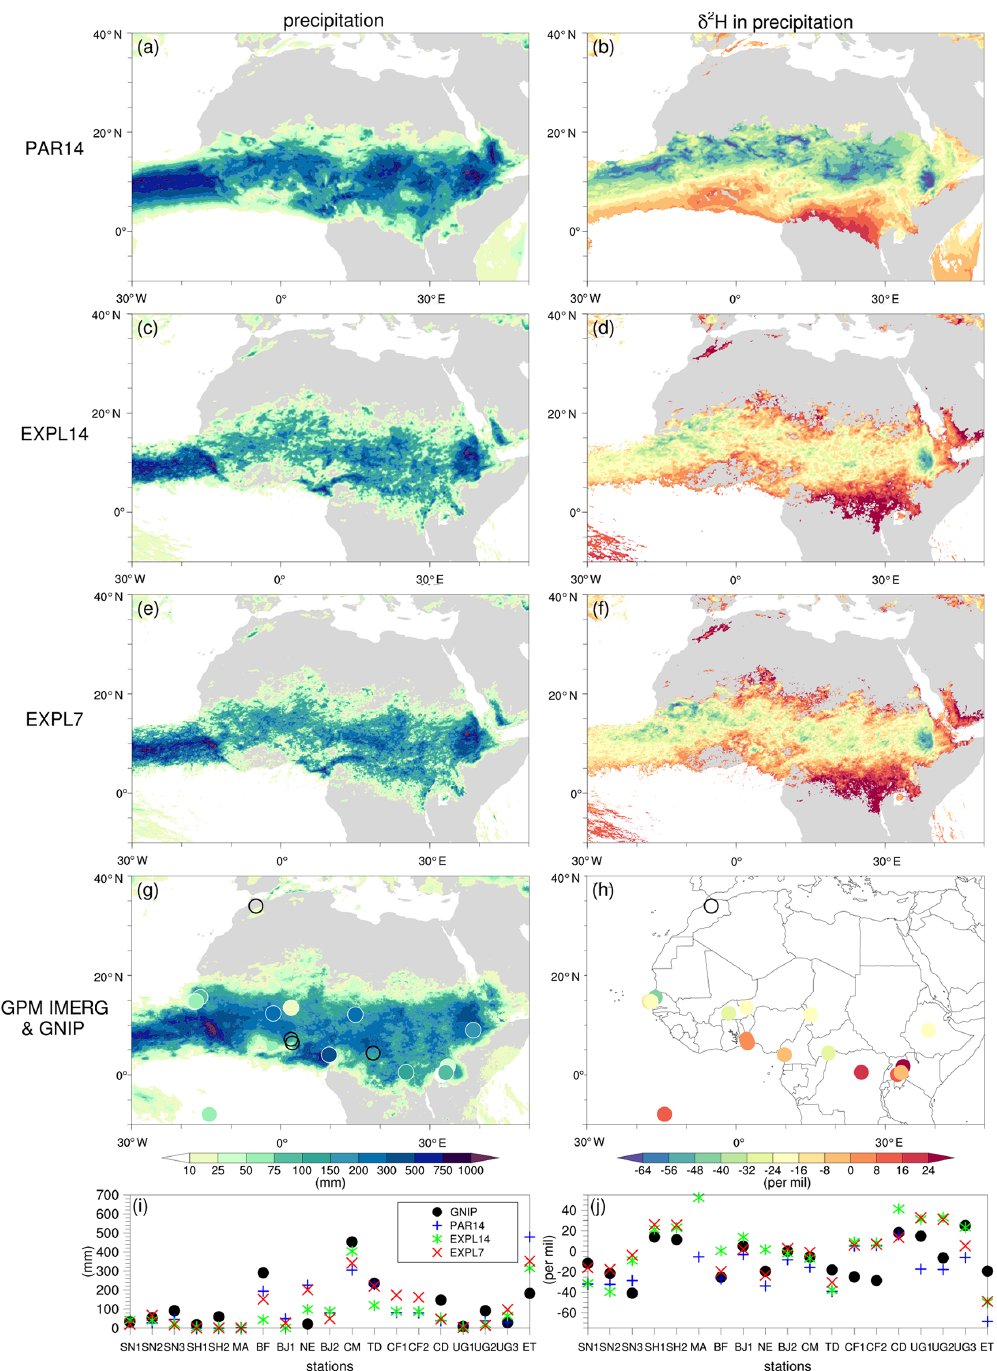
Figure 3. Monthly precipitation and its isotopic composition from the three model simulations and GNIP observations for July 2016. The panels show (left) precipitation amounts (mm) and (right) δ 2 H in precipitation (‰) in (a, b) PAR14, (c, d) EXPL14, (e, f) EXPL7, (g, h) GNIP observations, and (i, j) GNIP observations and COSMO iso simulation output, as indicated by the legend, at station locations. Precipitation outside the circles in panel (g) is from GPM IMERG, and open black circles in panels (g) and (h) denote missing values. COSMO iso output in panels (i) and (j) is interpolated at the station locations, and values are only plotted if the simulated precipitation amounts are larger than 1mm per month. GNIP stations in panels (i) and (j) are ordered by longitude from west to east: (SN1) Dakar Yoff, (SN2) Pout, (SN3) Louga, (SH1) Ascension Island, (SH2) Travellers Hill, (MA) Fes Sais, (BF) Bobo-Dioulasso, (BJ1) Bohicon, (NE) Niamey, (BJ2) Cotonou, (CM) Douala-Hydrac, (TD) N’Djamena, (CF1) Bangui-Universite, (CF2) Bangui-Sodeca, (CD) Kisangani, (UG1) Entebbe, (UG2) Jinja, (UG3) Bugondo, and (ET) Addis